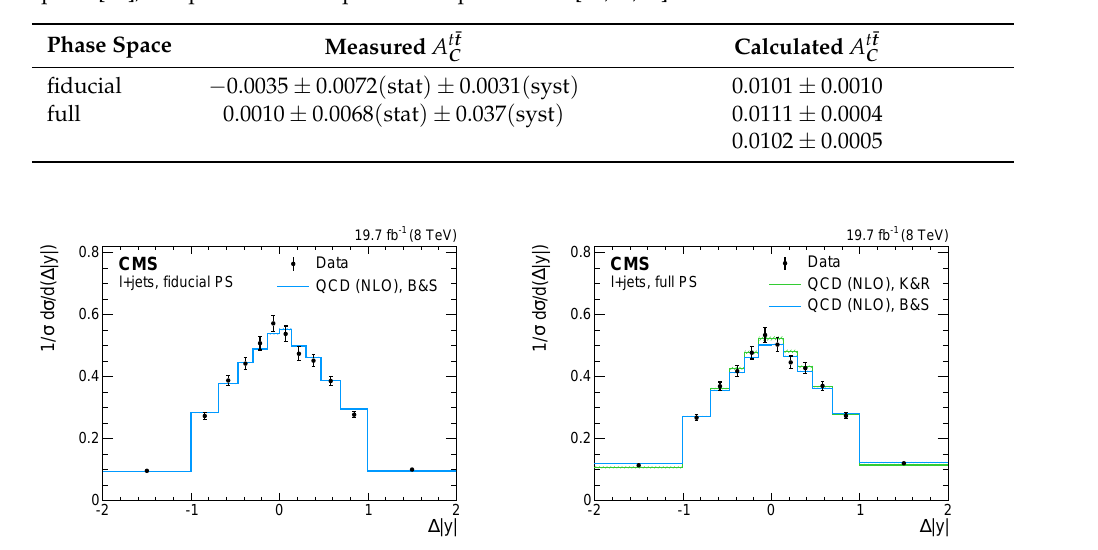
Table 5. Results of the inclusive t ¯ t charge asymmetry measurements in the fiducial and full phase space [50], compared to the respective SM predictions [13,14,52].